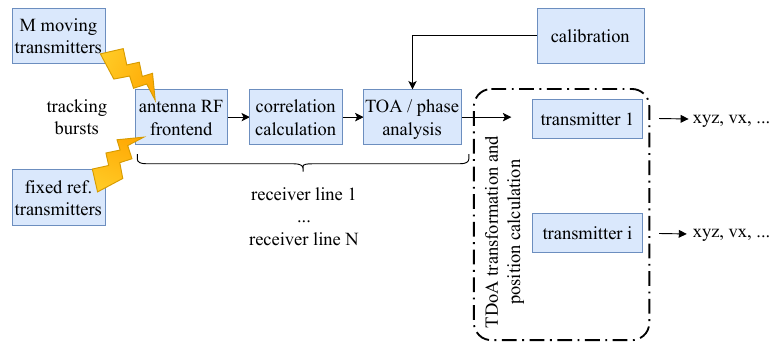
Figure 5. RedFIR’s signal processing chain.